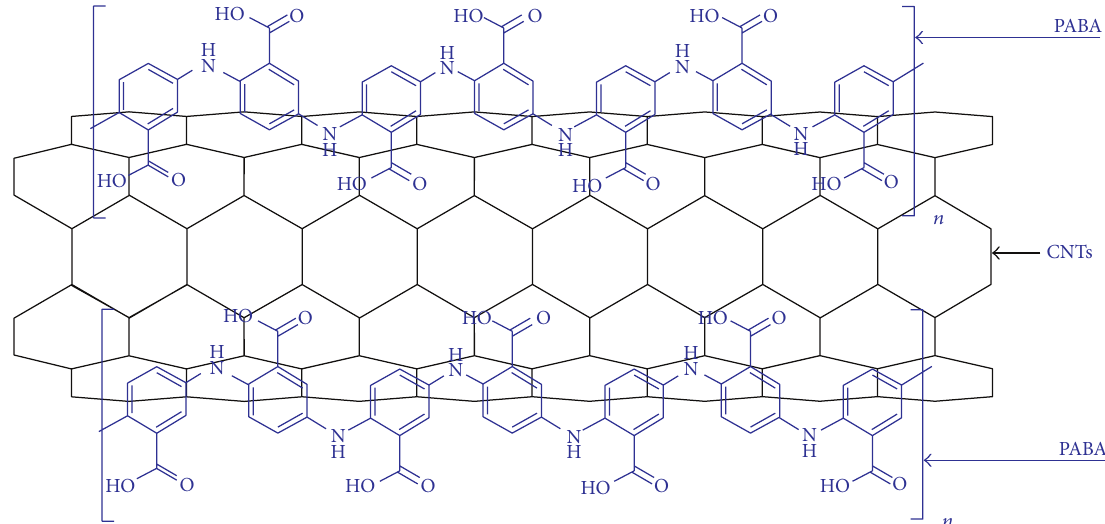
Figure 5: Schematic drawing of the proposed noncovalent attachment between PABA and MWNTs of the composite thin film.